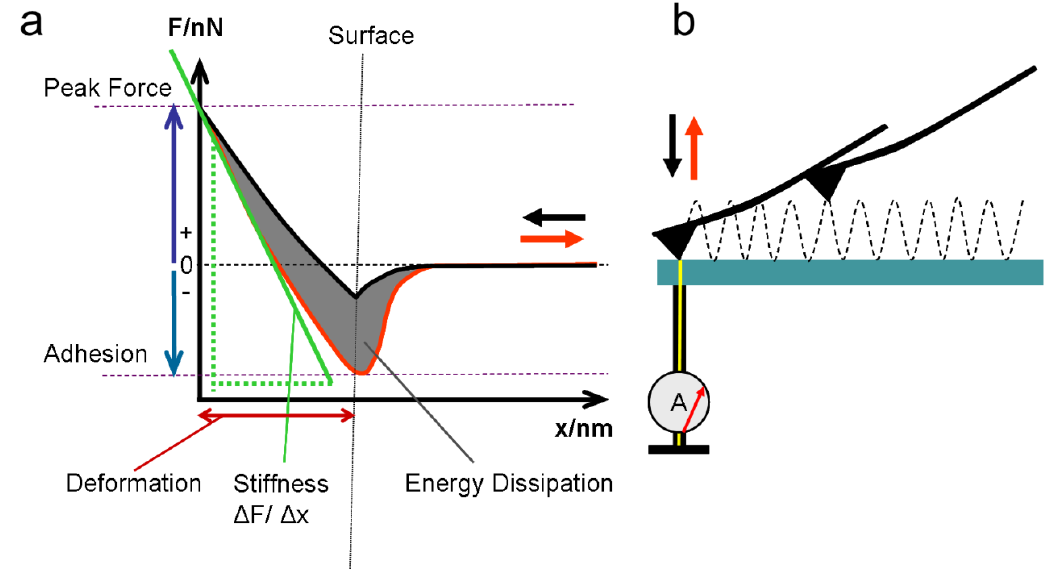
Figure 3. ( a ) Evaluation of mechanical properties from the force-separation curve; ( b ) The force-separation curve and evaluation of mechanical properties at every image